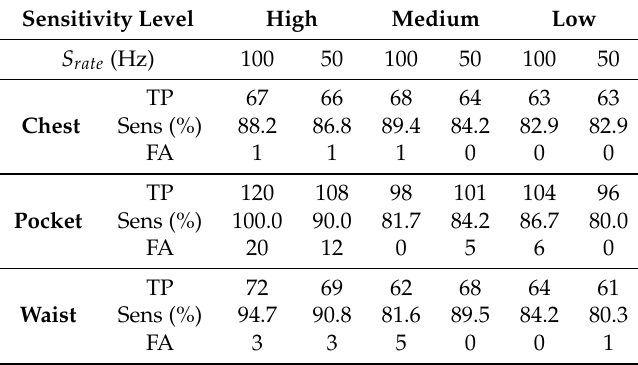
Table 5. Results by position and by frequency obtained by our algorithm when tested using the dataset DS-2